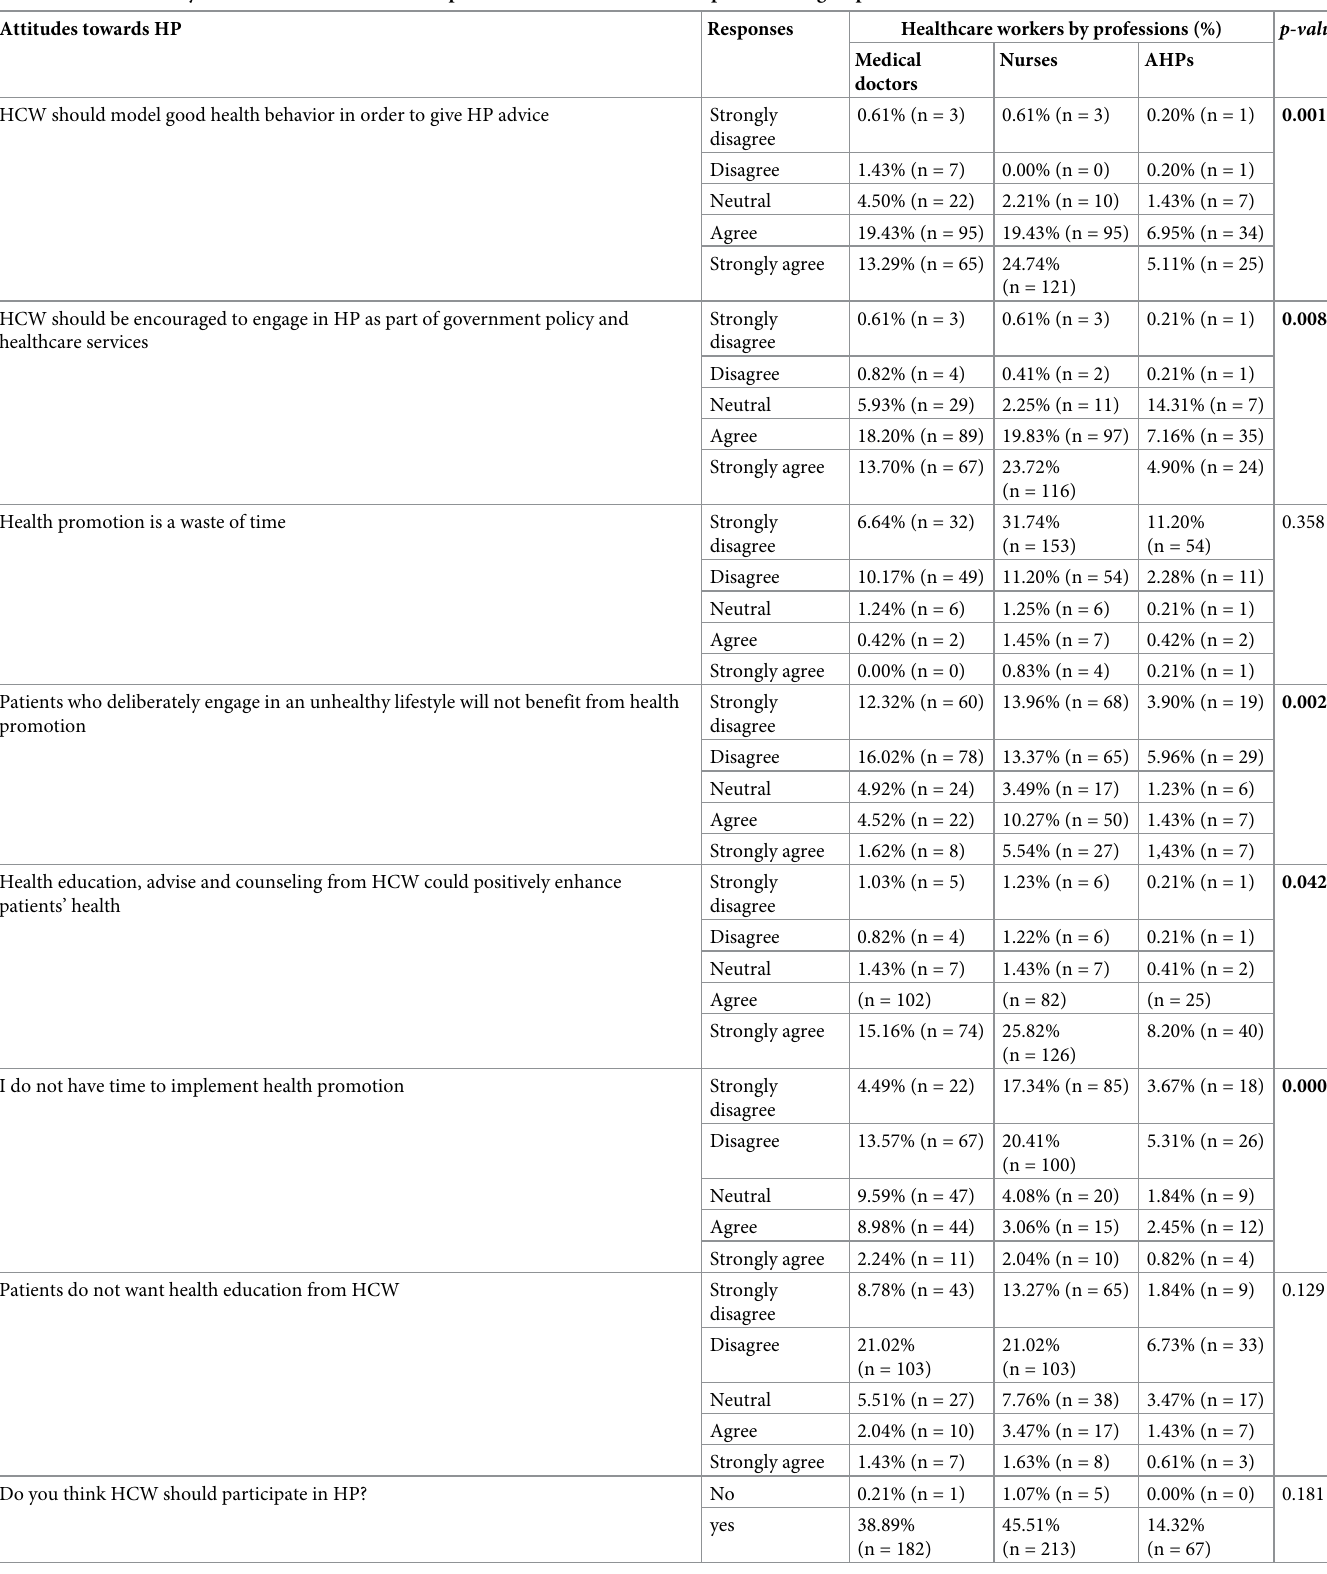
Table 4. Bivariate analysis of attitudes towards health promotion and each healthcare professional